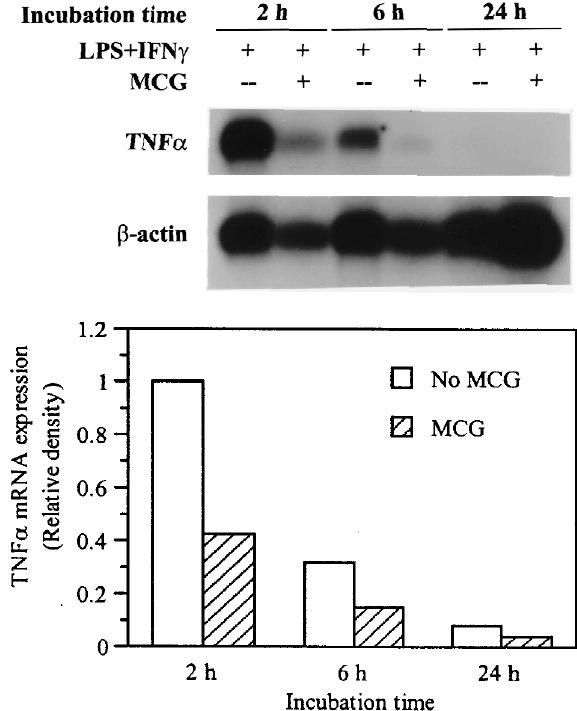
FIG. 5. Effect of MCG on macrophage TNF a mRNA expres- sion. Macrophages (1.5 3 10 7 ) were cultured without or with MCG (5 3 10 6 mast cell equivalent) and simultaneously activated with LPS + IFN g . After the indicated culture times, TNF a and b -actin mRNA were analysed by Northern blotting. The b -actin expression was used to normalize the data. This is representative of three